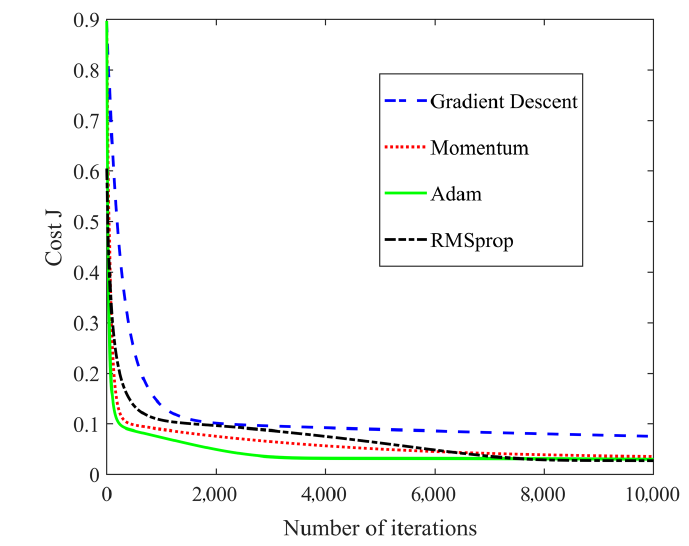
Figure 11. Loss curves with different optimizers.